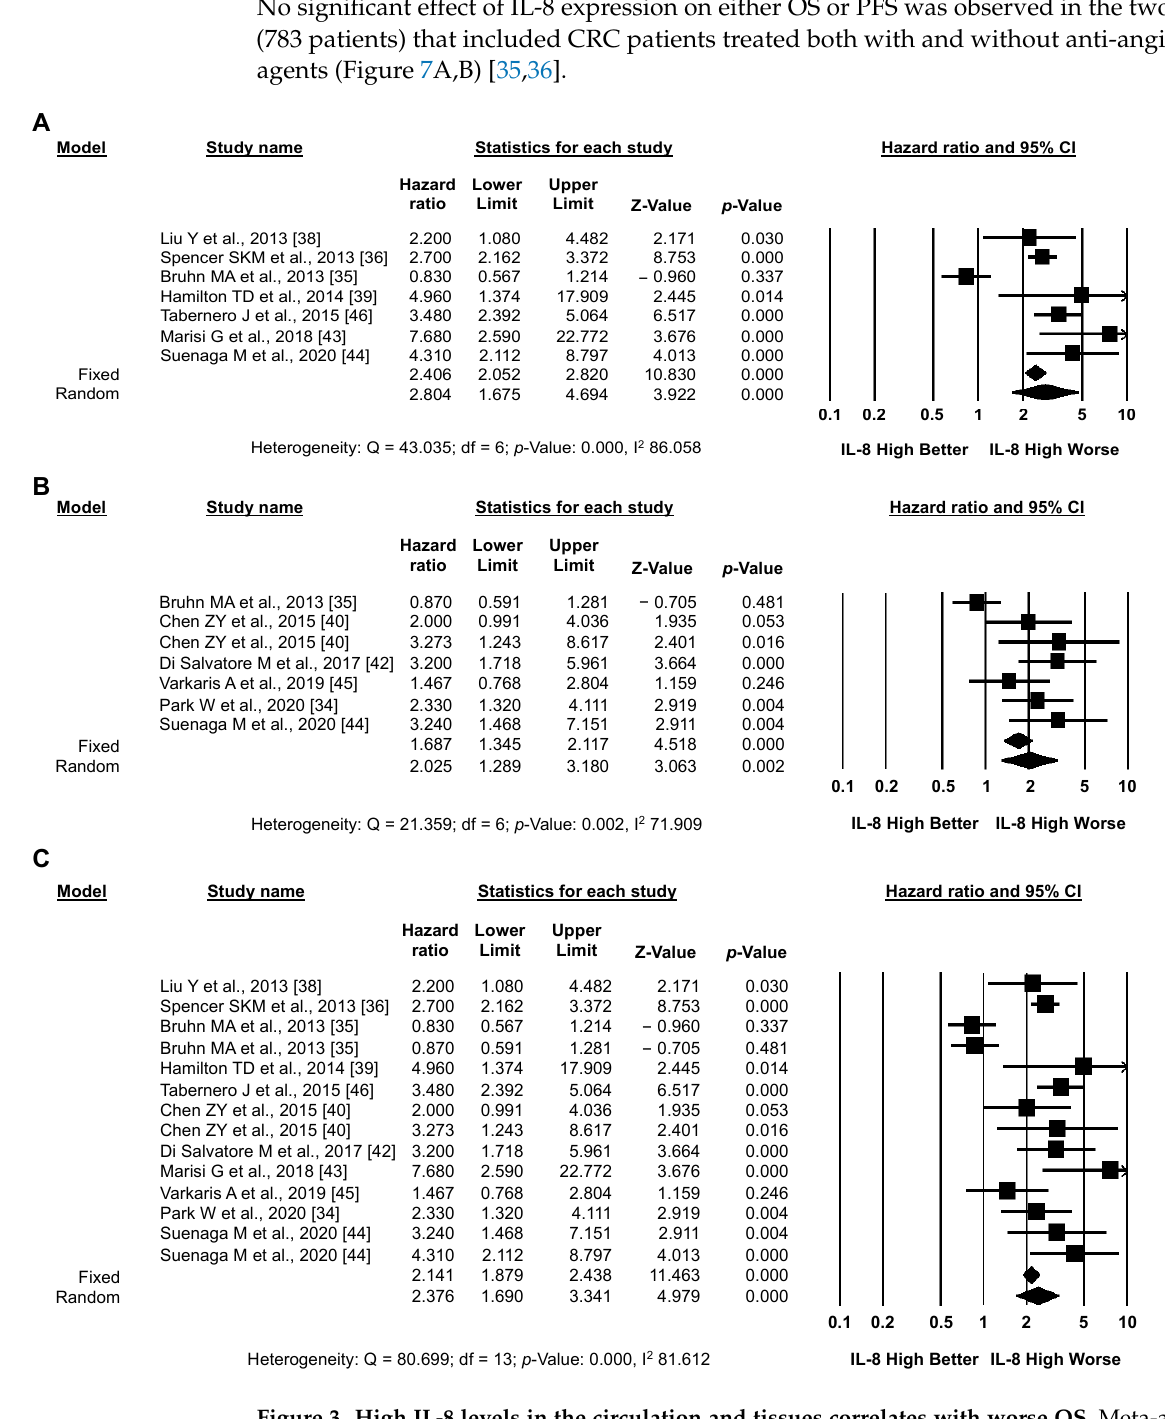
Figure 3. High IL-8 levels in the circulation and tissues correlates with worse OS. Meta-analysis of the HR for the association of high levels of IL-8 and unadjusted ( A ), adjusted ( B ), or unadjusted/adjusted ( C ) OS data.